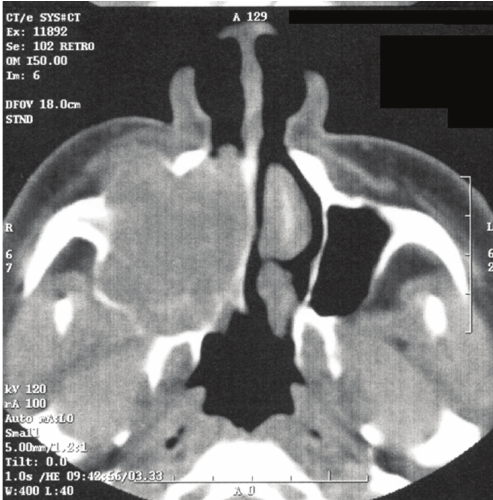
Figure 1: A preoperative CT showing a large lytic expansile, solid lesion extending from the nasopharynx area with obstruction of the ostiomeatal unit, and sphenoethmoidal recess into the lateral pharyngeal space, laterally to the parotid, without continuity with maxillary alveola and antrum.